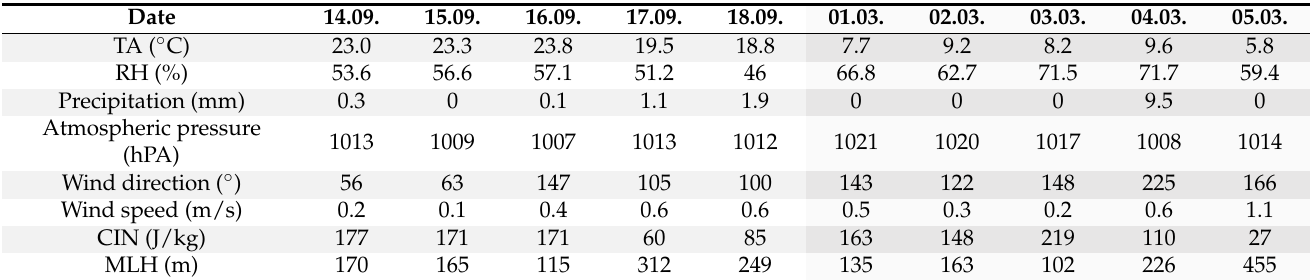
Table 1. Meteorological conditions during the study measurement periods in September and March including mean air temperature (TA) ( ◦ C), mean relative humidity (RH) (%), precipitation sum (mm), atmospheric pressure (hPA), wind speed (m/s), wind direction ( ◦ ), mean convective inhibition (CIN) (J/kg), and mean mixing layer height (MLH) (m). Adapted with permission from Refs. [18,44] 2021, Landesamt für Umwelt